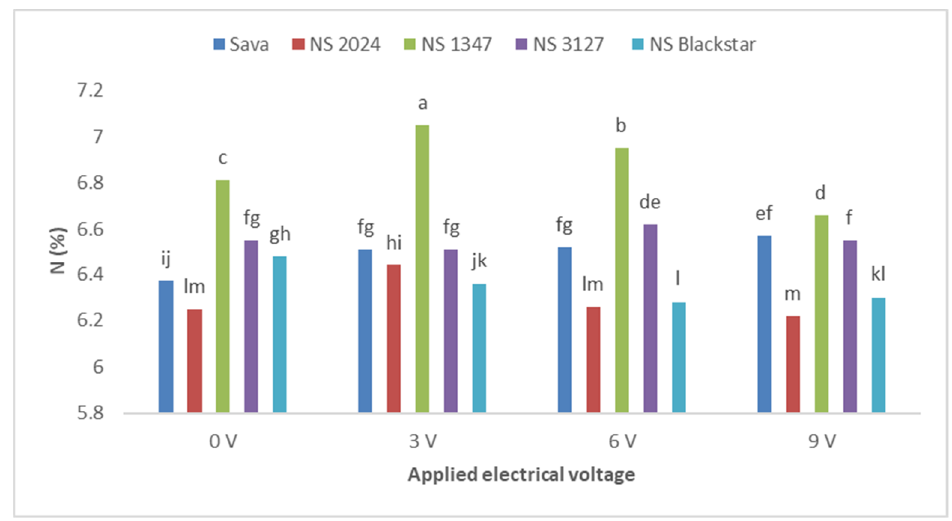
Figure 5. Effect of interaction soybean genotypes × electrostatic field on content nitrogen (N) in seedlings. Different letters above the bars represent significant differences at the p ≤ 0.05.